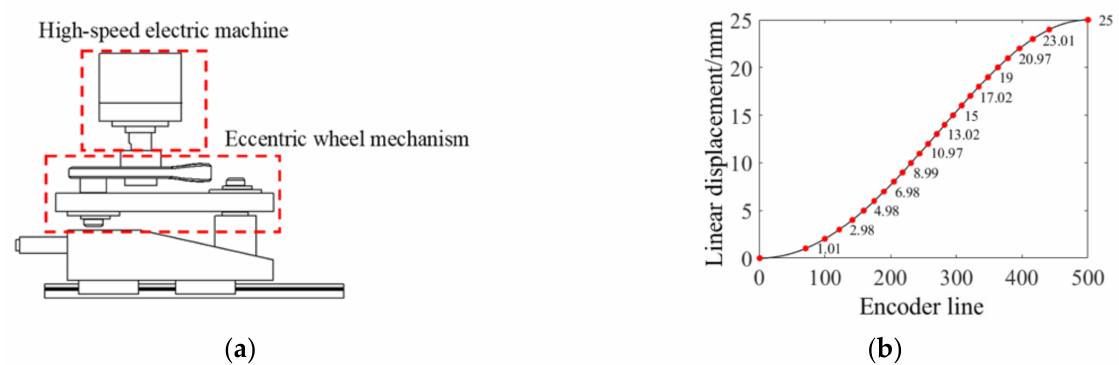
Figure 6. High-speed scanning positioning structure: ( a ) wheel motion mechanism; ( b ) theoretical coordinates of the treatment